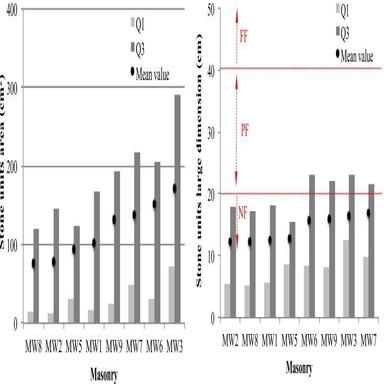
Stone units area (left) and largest dimension (right).